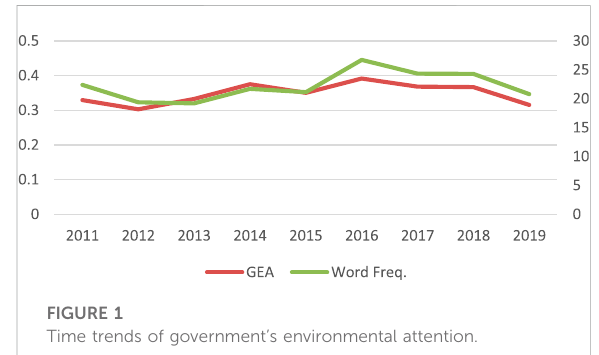
FIGURE 1 Time trends of government ’ s environmental attention.